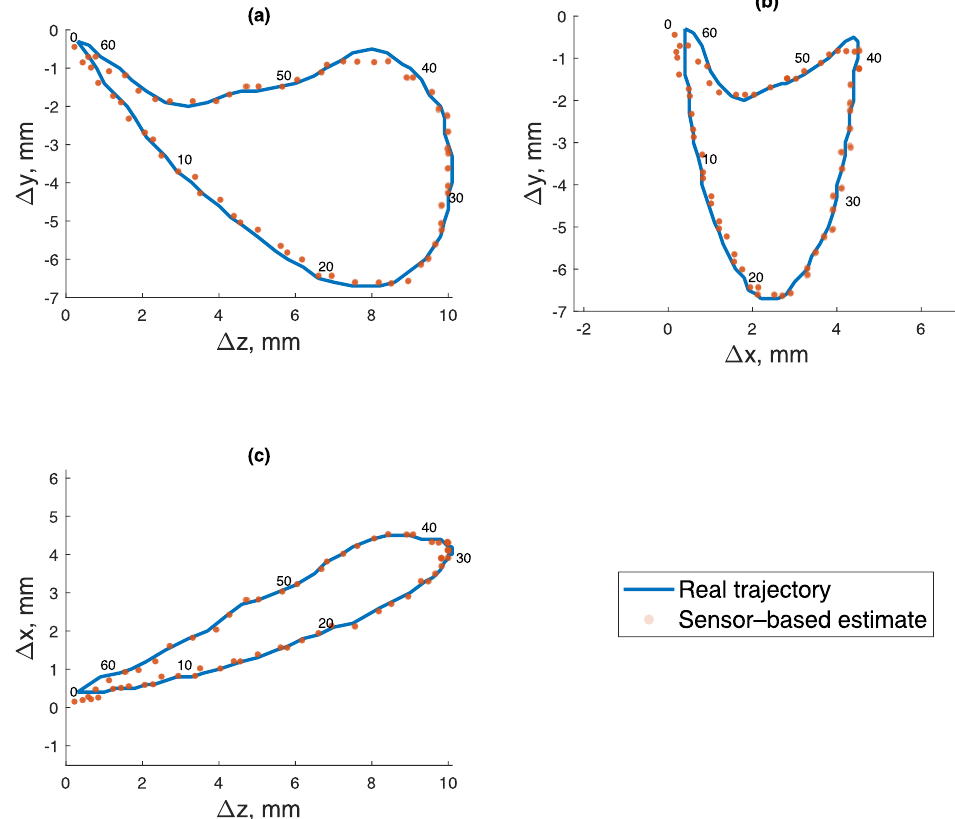
Figure 11. Masticatory test trajectory calculated from magnetic field values. Measured points are numbered 0 to 62, and all 10 iterations are represented in transparent markers. ( a ) Lateral–vertical view (z-y). ( b ) Protrussive–vertical view (x-y). ( c ) Lateral–protrussive view